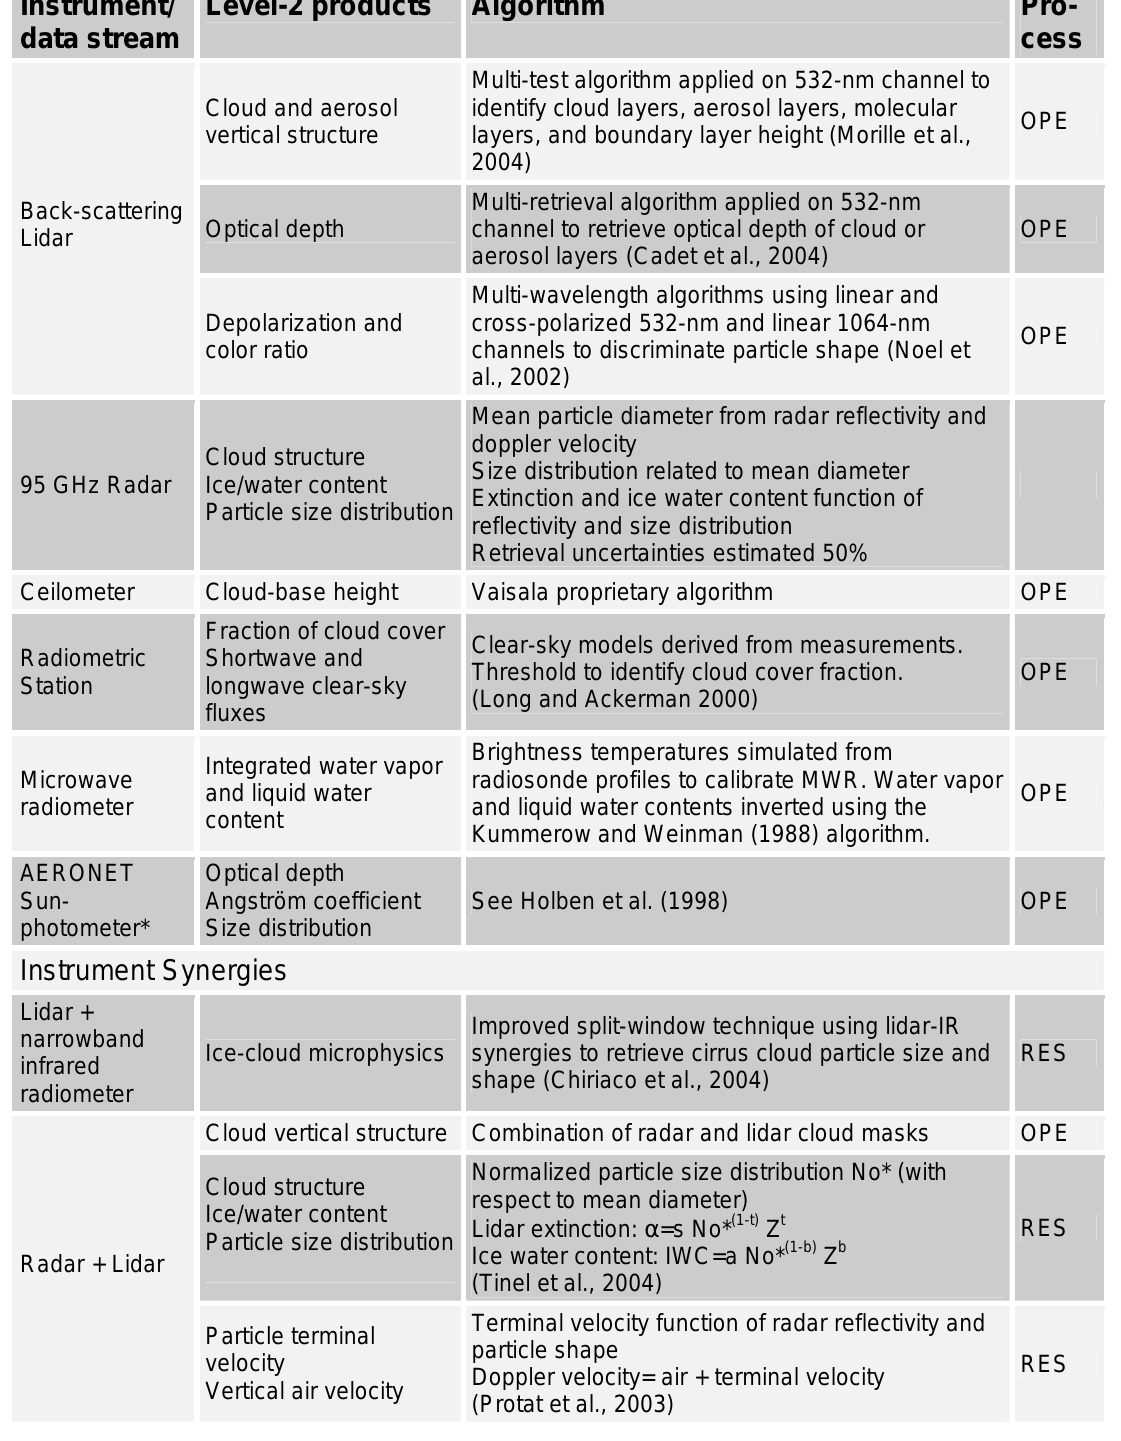
Table 5. Retrievals of atmospheric properties (level-2 data) from single or multiple instruments require developments of specific algorithms and are part of active areas of research. *Sun-photometer data should be ordered directly from AERONET.